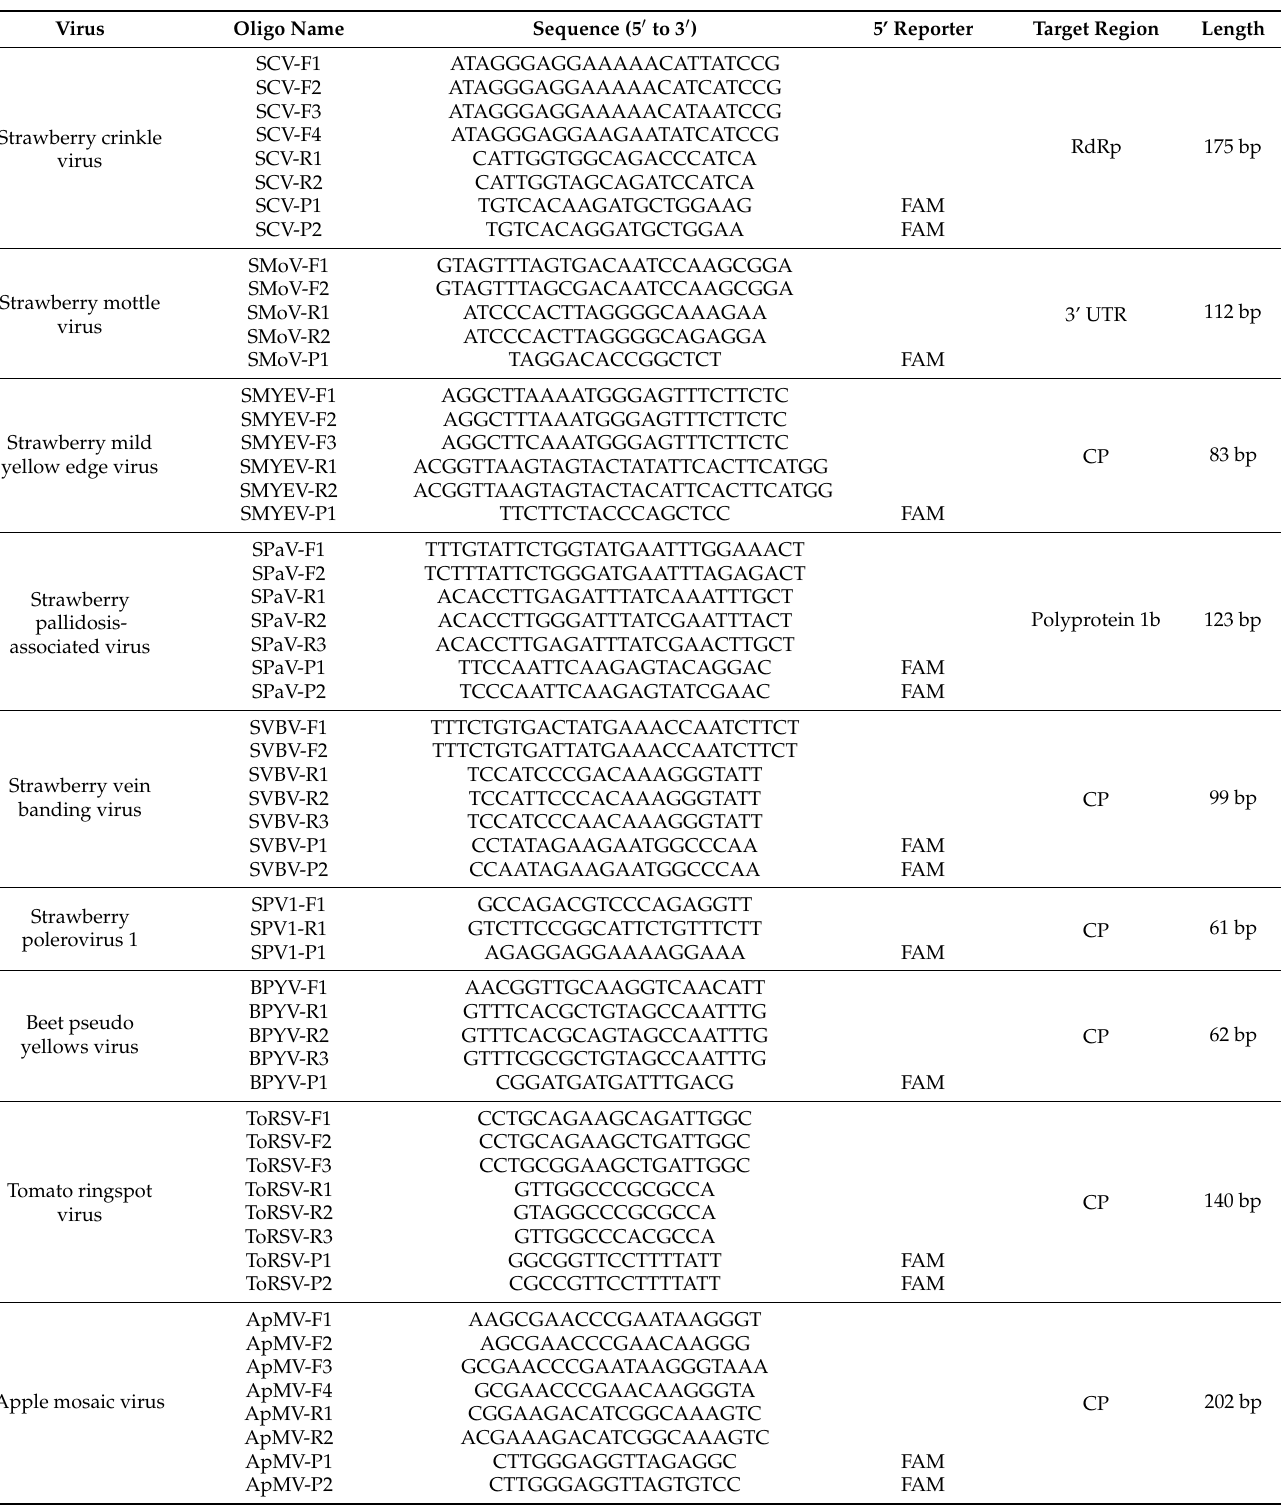
Table 3. Newly designed assays for detection of strawberry-infecting